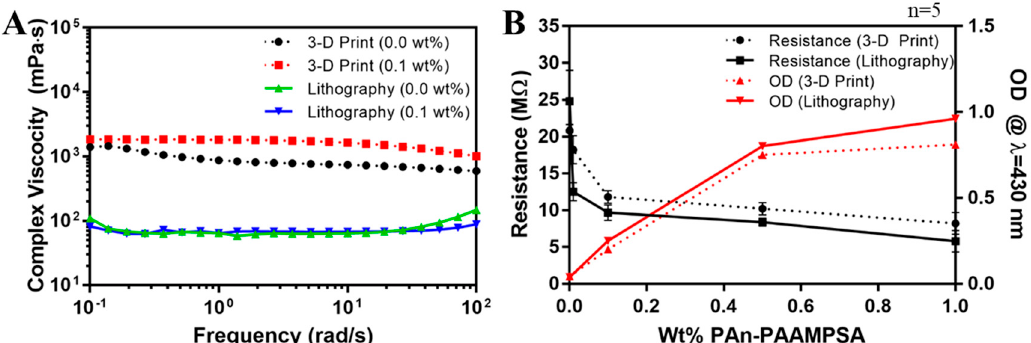
Figure 5. ( A ) Complex viscosities of hydrogel cocktails formulated for microlithography (2 mol% pNVP) and 3-D printing (12 mol% pNVP) and containing 0.00 and 0.10 wt% PAn-PAAMPSA. ( B ) Two-point DC resistance (M Ω ) and optical density (OD) at λ = 430 nm of p(HEMA- co -HMMA- co -PEGMA) hydrogels containing at 0.00, 0.01, 0.10, 0.50, and 1.00 wt% PAn-PAAMPSA.